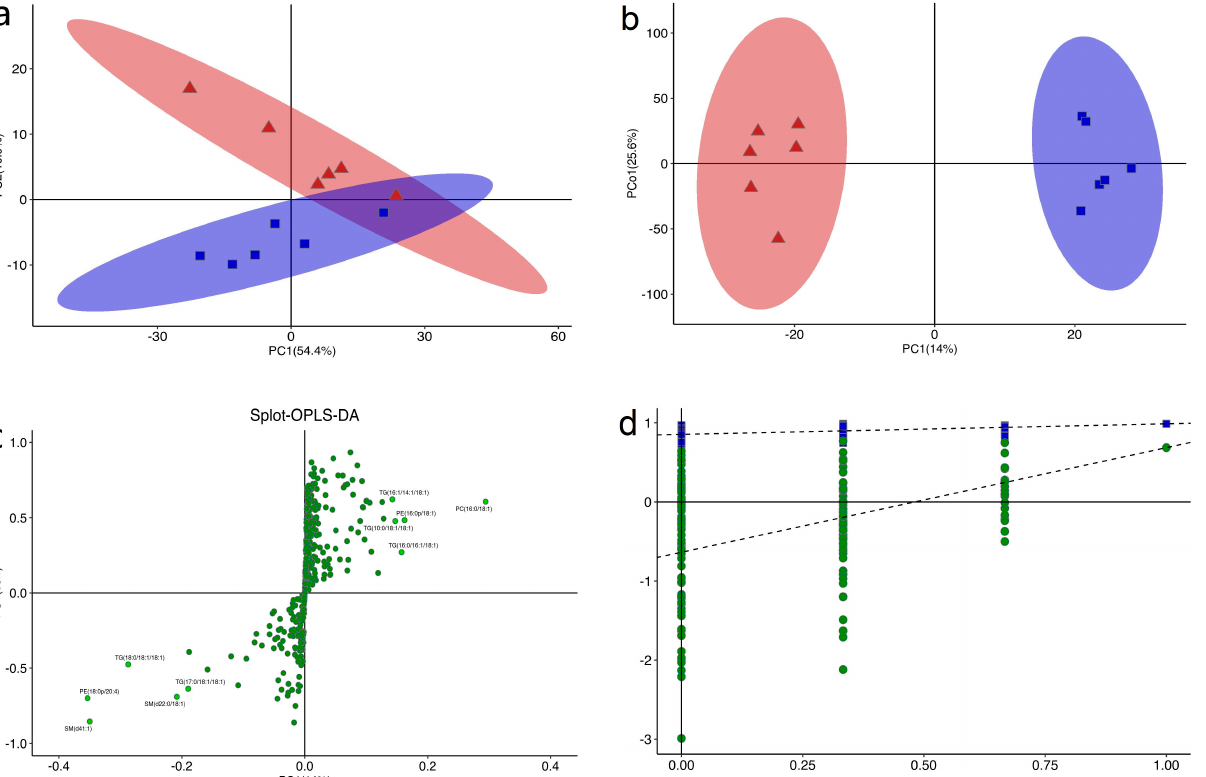
Figure 1. ( a ) The score plots of principal component analysis (PCA) of lipids in the subcutaneous fat of yaks under stall (SF) and graze feeding (GF). Red and blue represented the SF and GF groups, respectively. ( b ) The score plots of orthogonal partial least squares discriminant analysis (OPLS-DA) of lipids in the subcutaneous fat of yaks under SF and GF. ( c ) The splot diagram of OPLS-DA. ( d ) Permutation test of OPLS-DA model.